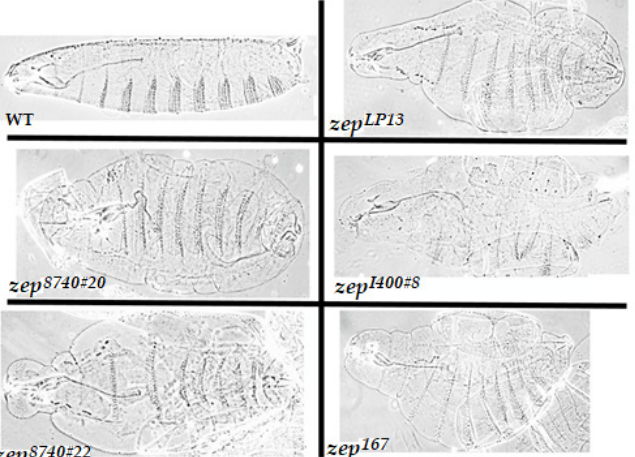
Figure 3. Expanded cuticle phenotypes of the strongest zep alleles. zep LP13 and zep I400#8 contain stop codons (see Figure 4) whereas zep 8740#20 , zep 8740#22 , and zep 167 delete Gfat1 plus two or more flanking genes (see Figure S1). A wildtype (Oregon-R) embryo is shown in the top left panel. Homozygous mutant and wildtype embryos were prepared as described in Ostrowski et al. [24] The embryos are oriented with anterior to the left and posterior to the right. Note the pronounced bloating of the mutant embryos relative to wildtype.